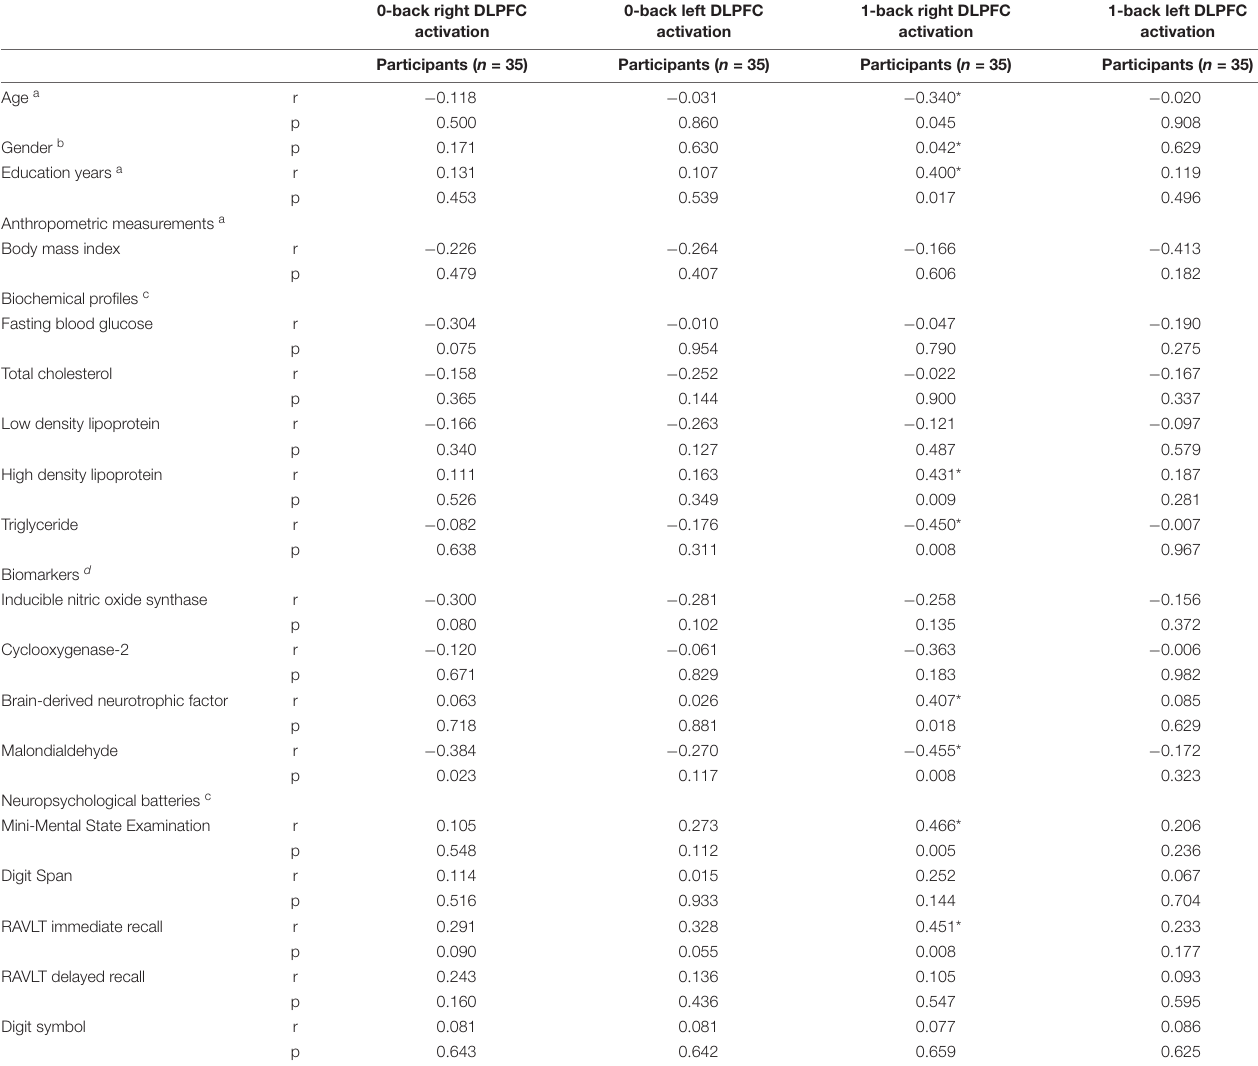
TABLE 3 | Relationship between demographic characteristics, anthropometric measurements, biochemical indices, and cognitive tests with dorsolateral prefrontal cortex (DLPFC) activation ( n =